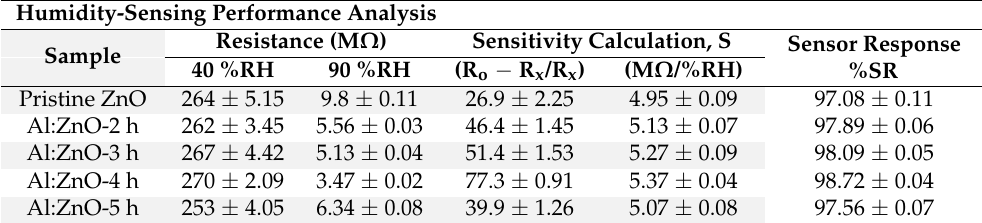
Table 3. Average resistance, sensitivity, and sensing response of the pristine ZnO and Al:ZnO nanostructured-based flexible humidity